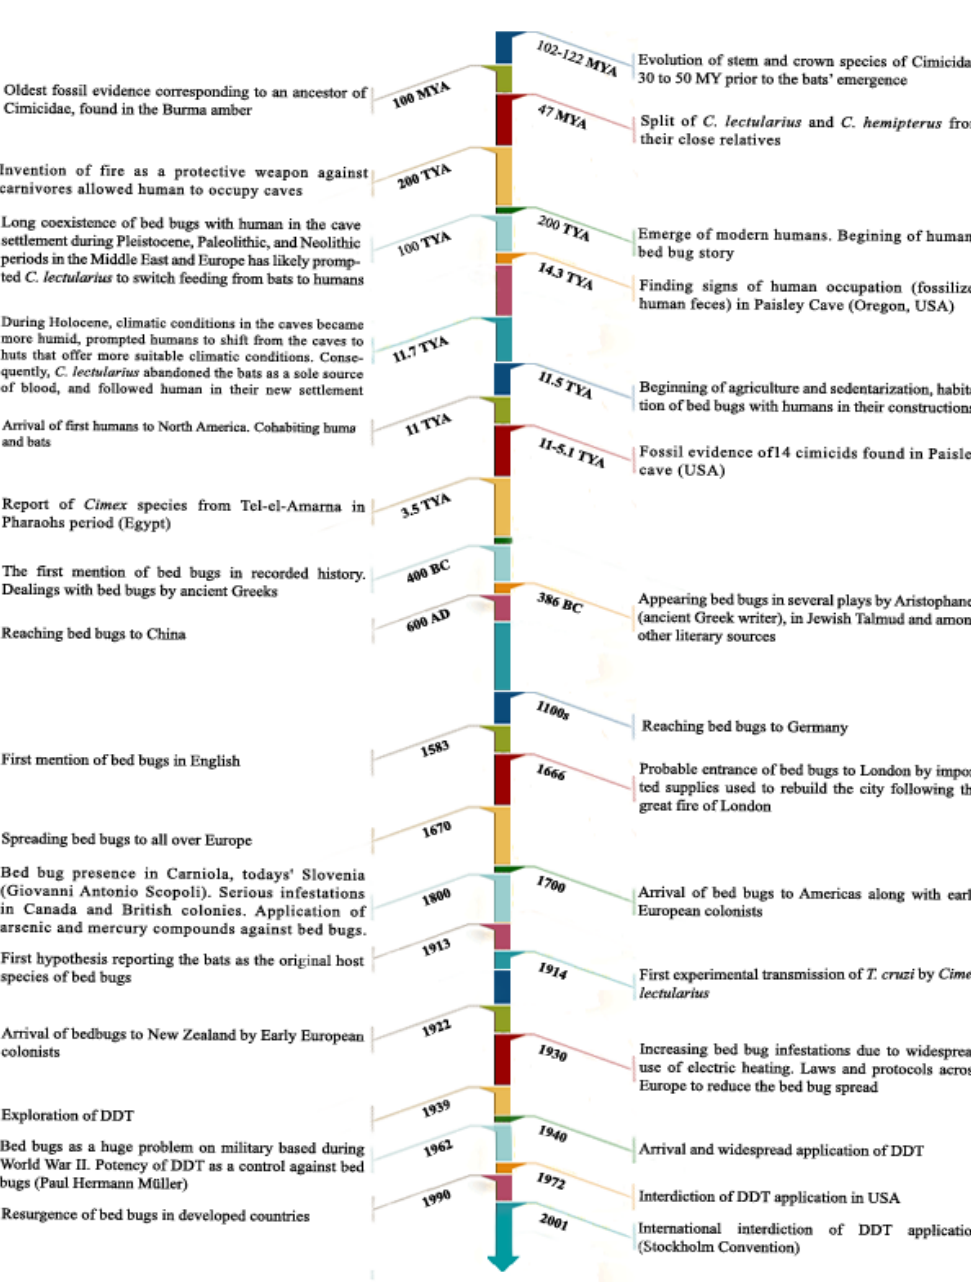
Figure 4. History of the description of bed bugs according to literature [17,65,74]. MYA: Million Years Ago. TYA: Thousand Years Ago.